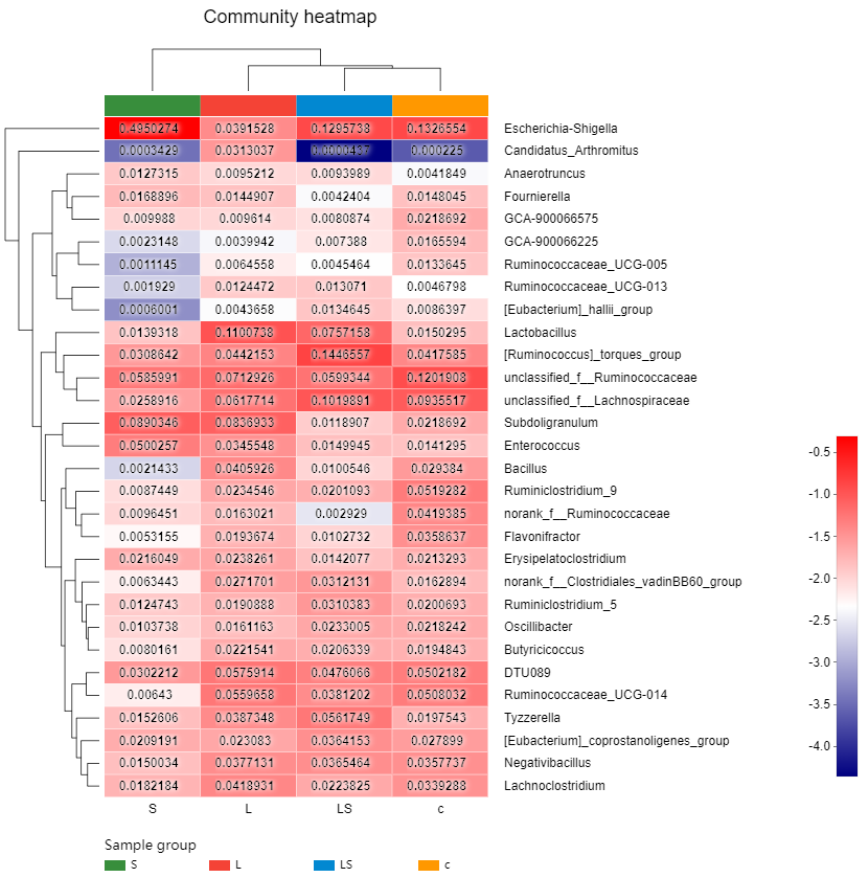
Figure 5. Heat map analysis of relative abundance of cecum intestinal flora of chickens after L. reuteri S5 intervention. The variation of the abundance of different species in the sample is displayed through the color gradient of the color block, and the numbers in the figure represent the relative abundance value of the species.